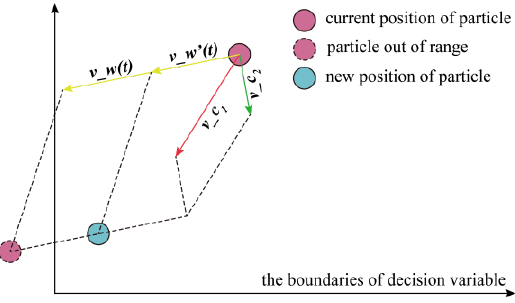
Figure 7. Improved particle boundary processing method.